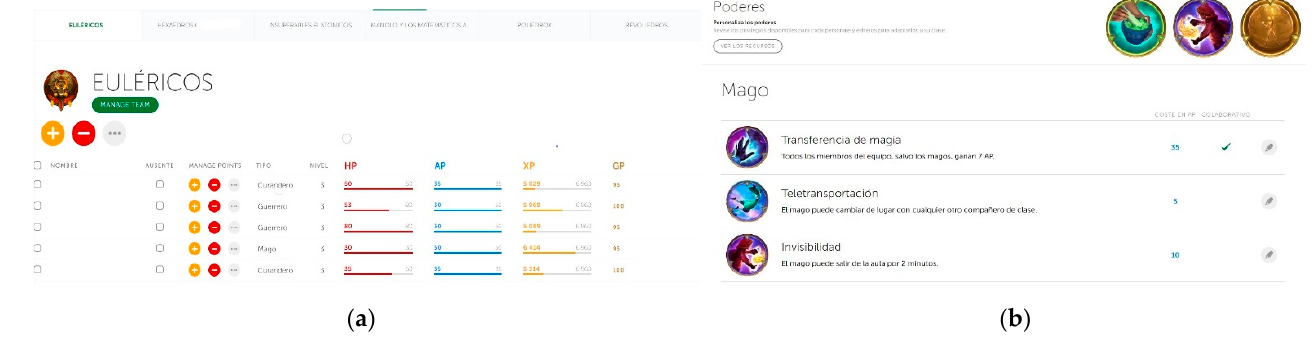
Figure 3. Capture of a moment of the simulation of point acquisition (diagram in “Machinations”, symbols equivalence: triangle=source; circle=pool; triangle with line = converter; rhombus=gate). Leader boards are established as students gain points in cooperative teams and by the whole group in a class, as shown in Figure 4 (see Section 3.1 for more details).